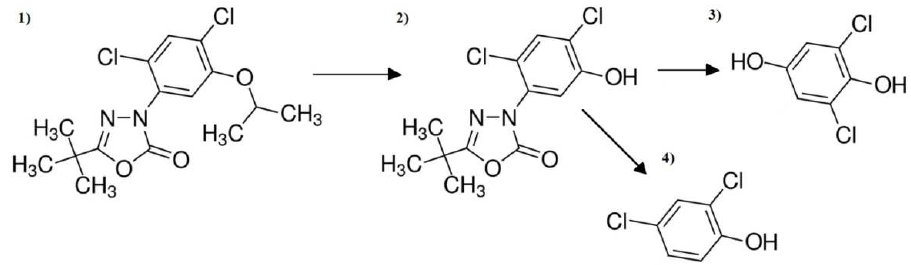
Figure 12. ( 1 ) ODZ decomposition by-products: ( 2 ) 9-tert-Butyl-3-(2,4-dichloro-5-hydroxyphenyl)- 1,3,4-oxadiazol-2(3H)-one, ( 3 ) 2,6-Dichlorohydroquinone and ( 4 )